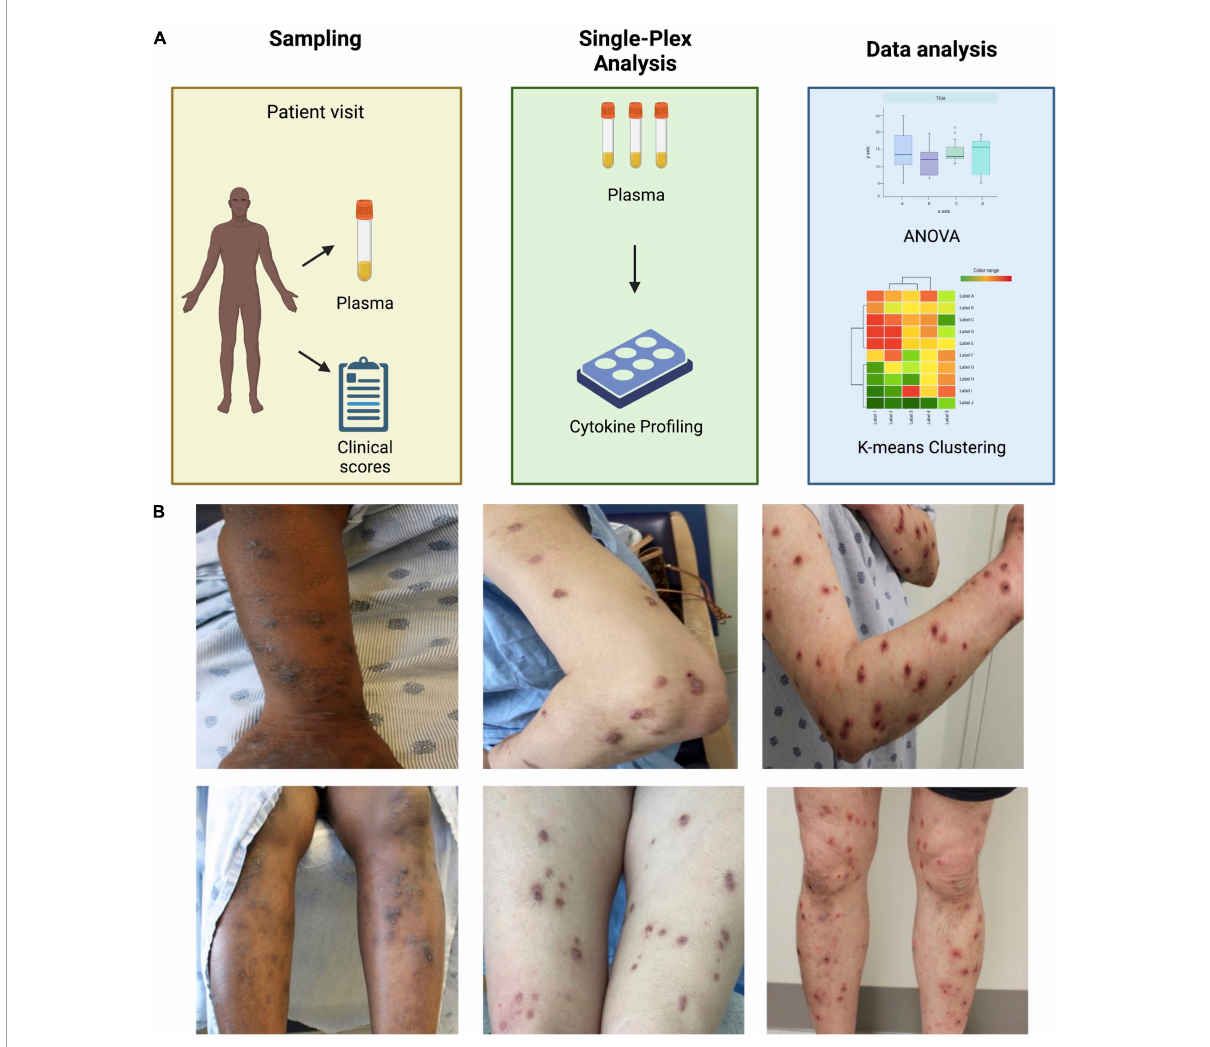
FIGURE1 (A) Schematic of methods. (B) Representative images of prurigo nodularis